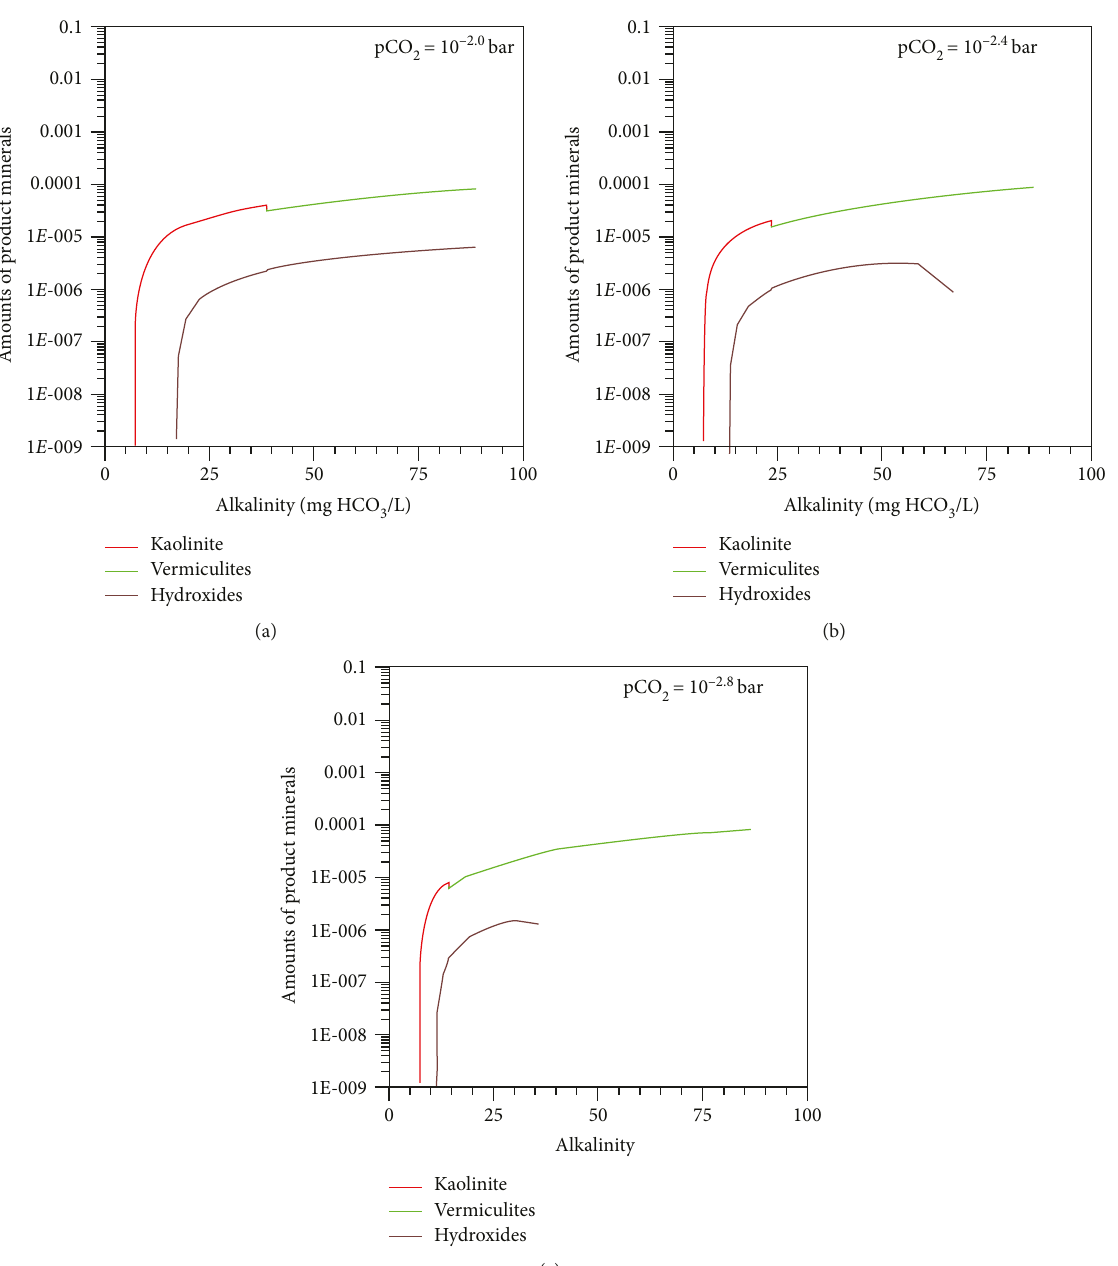
Figure 6: Moles of solid product phases against alkalinity, showing the results of reaction path modeling for the dissolution of granulite (a) pCO of 10 -2.0 bar, (b) pCO of 10 -2.4 bar, (c) pCO of 10 -2.8 2 2 2